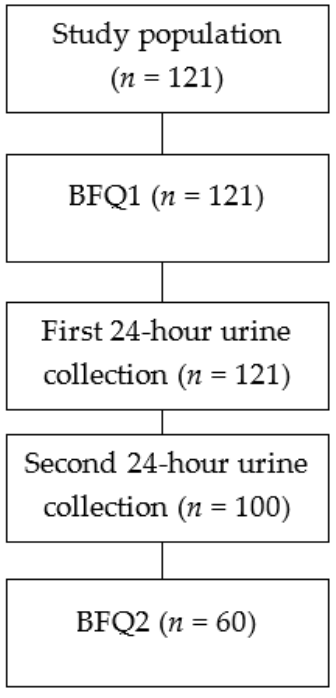
Figure 1. Flow chart of the stages of the study. BFQ: beverage frequency questionnaire.